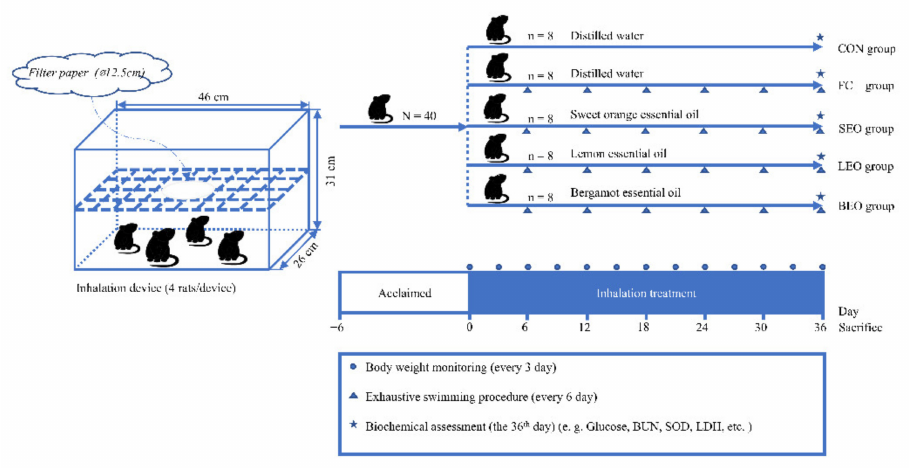
Figure 8. Experimental procedure for the effects of inhalation of the CEOs on exercise-induced